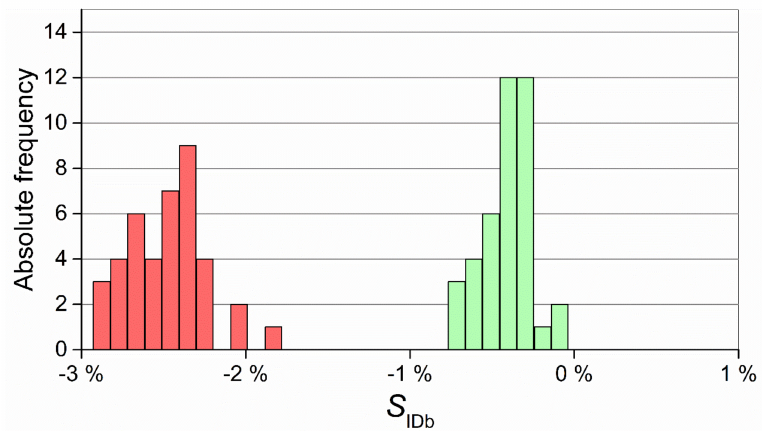
Figure 16. Distribution of SIDb values for IM (red) and µ IM (green).